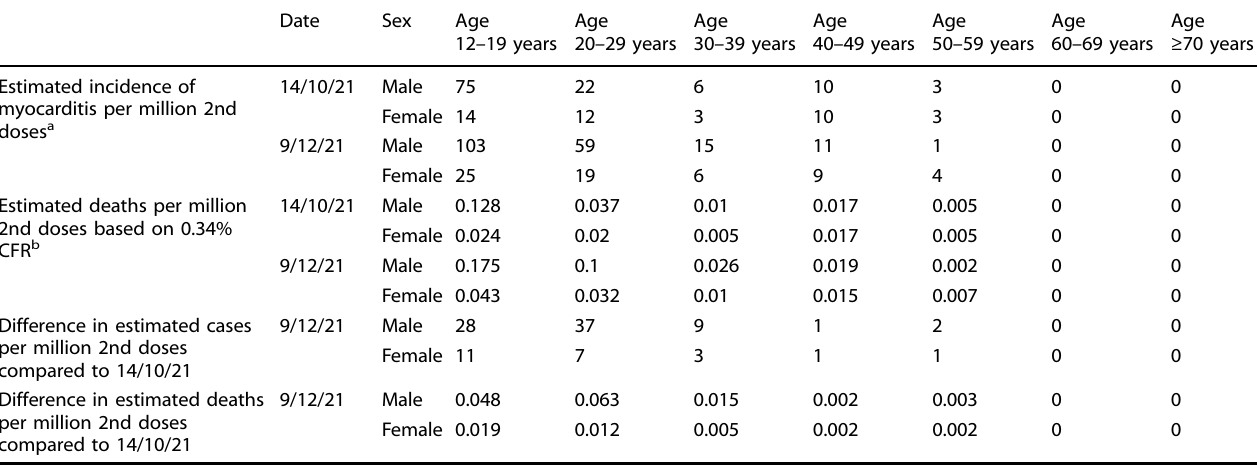
Table 2. Evolving evidence on incidence of P fi zer vaccine-associated myocarditis by age and sex in Australia in October – December 2021. Date